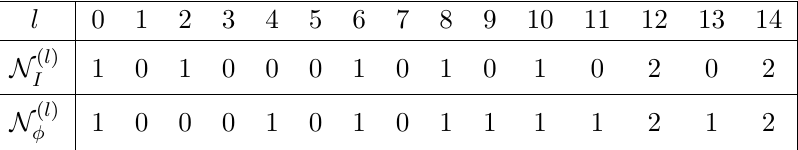
and N ( l ) of the level l subspaces in ˆ V 0 and ˆ V 0 − 1 / 5